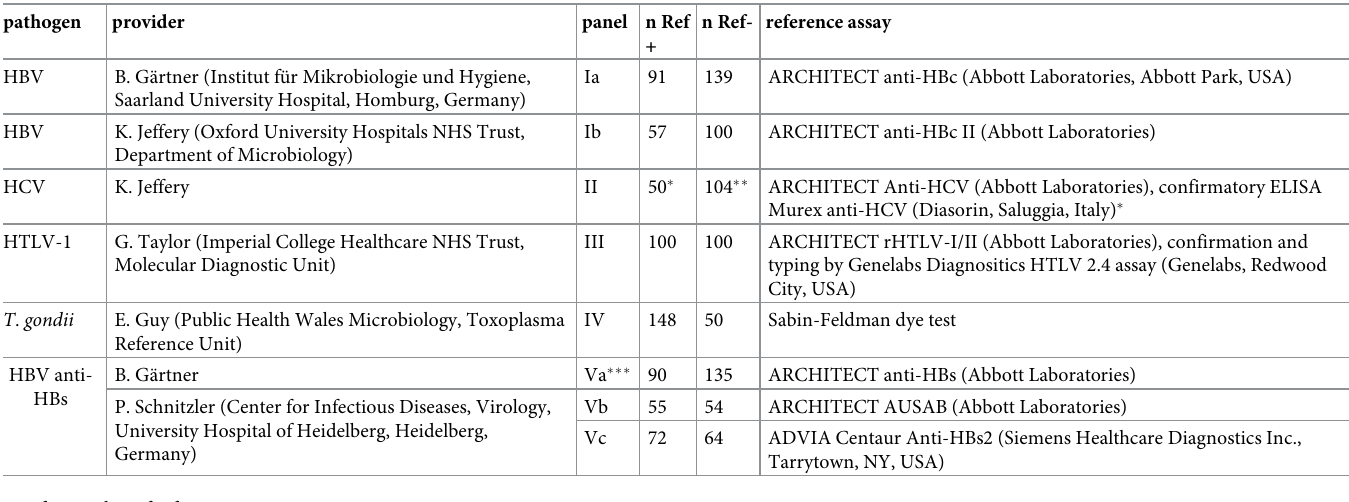
Table 2. Characteristics of reference serum